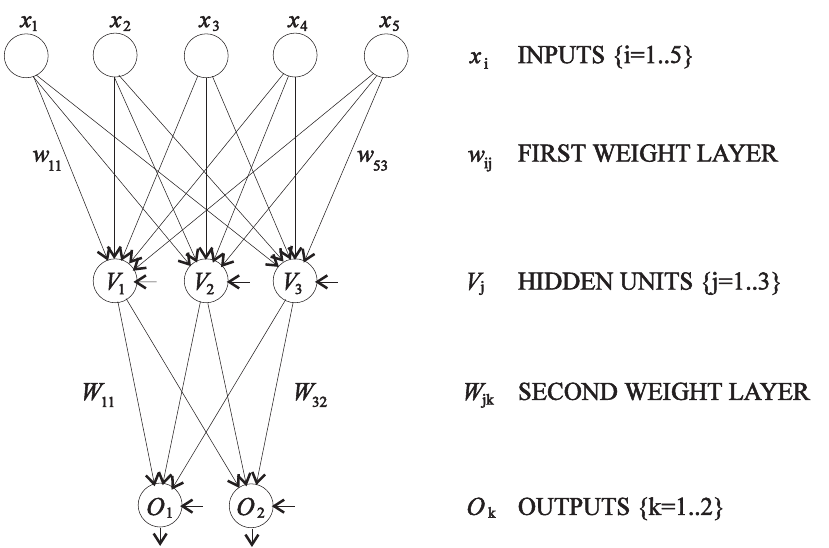
Fig. 1. Structure of a feed-forward neural network with one layer of hidden units. Biases to non-input units are shown as horizontal arrows leading into the units. This process is repeated for as many layers of weights as exist in the